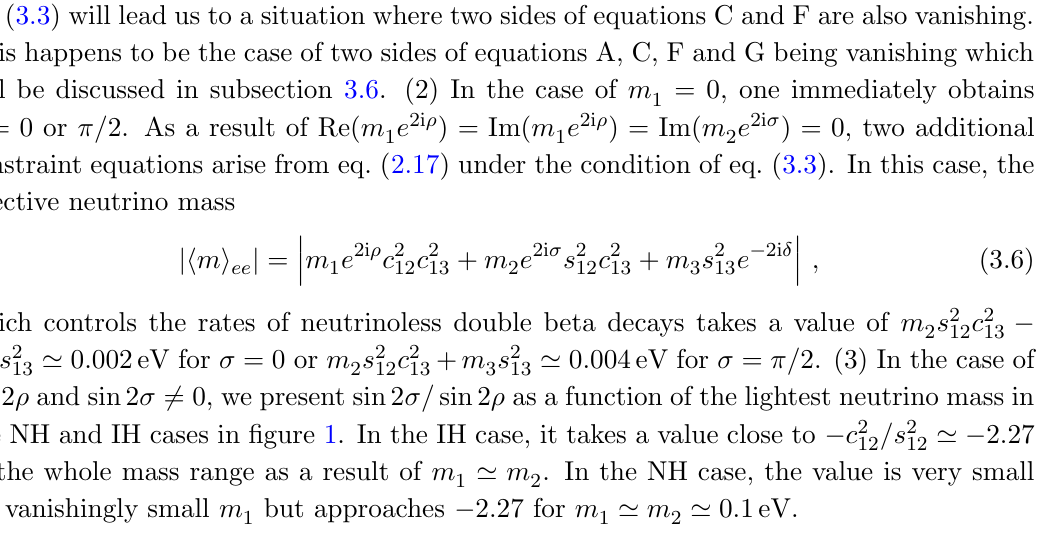
Figure 1 . sin 2 (cid:27)= sin 2 (cid:26) as a function of the lightest neutrino mass ( m the IH case) in the case of two sides of equations A and G being